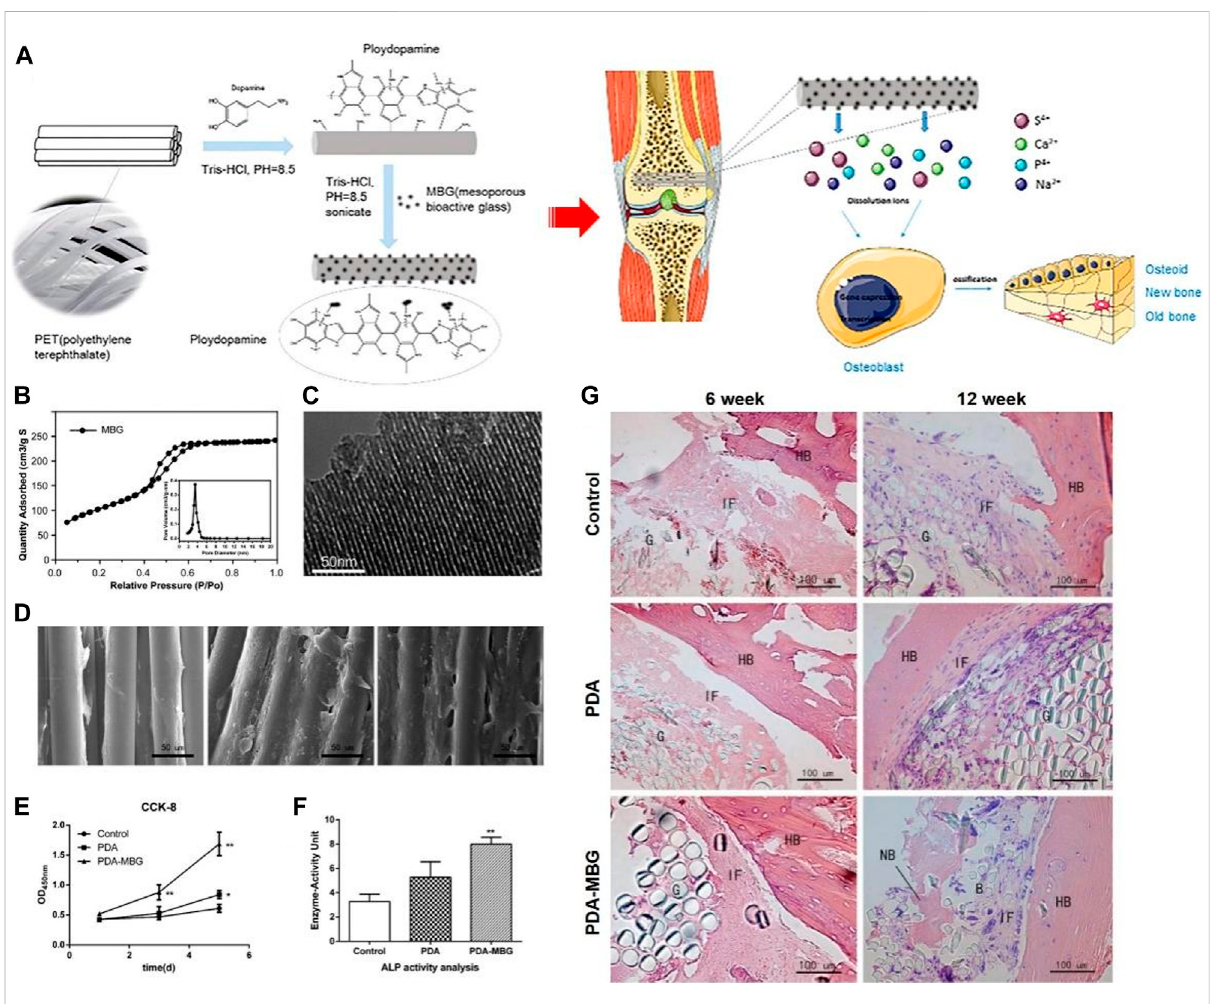
PET based arti fi cial ligament coated with dopamine and mesoporous bioactive glass enhanced the bioactivity and osseointegration in bone tissue engineering (Yu et al., 2017). (A) Schematic diagram of PET coated with PDA-MBG and its application. (B) Adsorption-desorption isotherm of MBG. (C) TEM of MBG. (D) SEM images of MC3T3-E1 cells cultured on different scaffolds. (E) CCK-8 results of MC3T3-E1 cells cultured on different scaffolds. (F) ALP activity of MC3T3-E1 cells cultured on different scaffolds after 7 days of incubation. (G) HE staining of different scaffolds